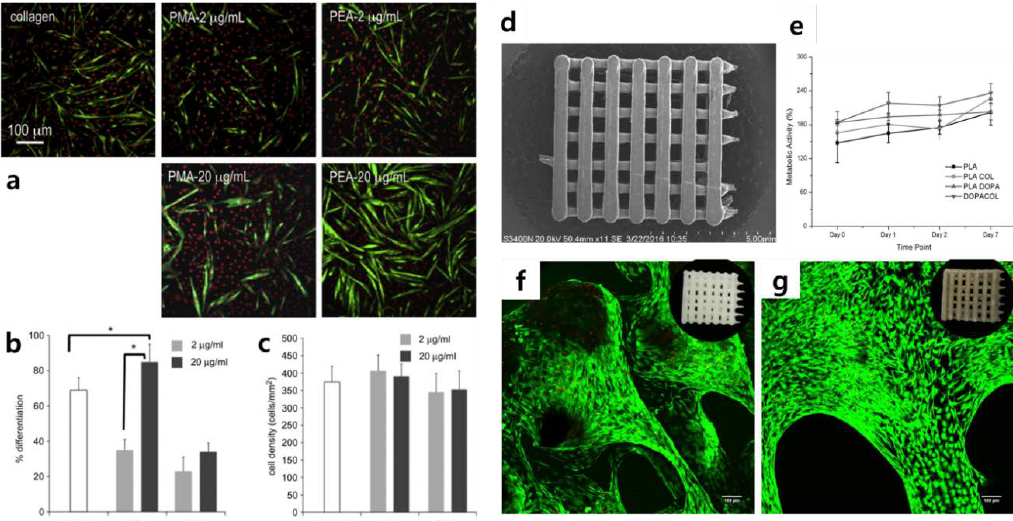
Figure 2. ( a ) Myogenic differentiation with different conditions. Myosin-positive cells and nuclei are marked in green and red, respectively. ( b ) Myogenic differentiation and ( c ) cell density with different FN concentrations. ( d ) Scanning electron microscopy image of poly(lactic acid) (PLA) scaffolds. ( e ) Metabolic activity of mesenchymal stem cells (MSCs) cultivated in PLA scaffolds with different coating materials. Results of Alamar Blue assay for cells cultured on ( f ) PLA scaffolds and ( g ) DOPA COL scaffolds. ( a – c ) The reprint of this figure from [54] is permitted by Elsevier. ( d – g ) The reprint of